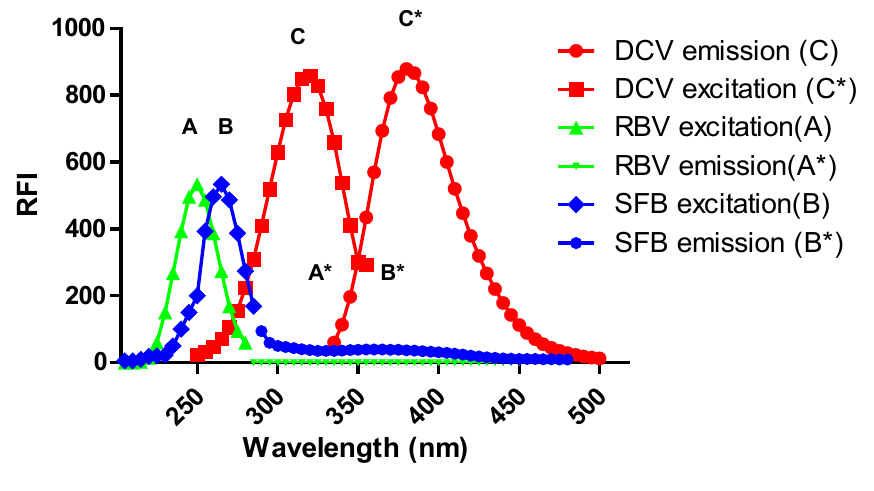
Figure 2: Excitation and emission spectra of RBV (A, A*), SFB (B, B*), and DCV (C, C*) in spiked human